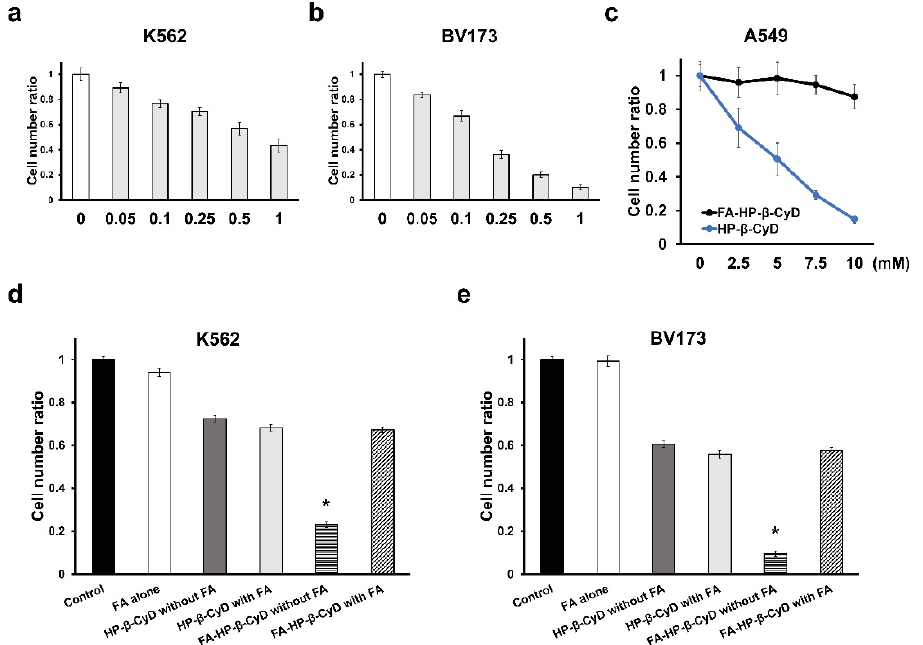
Figure 3. Antitumor effect of FA-HP- β -CyD. ( a , b ) Antitumor activity of FA-HP- β -CyD (0, 0.05, 0.1, 0.25, 0.5, and 1.0 mM) in K562 and BV173 cells. Cells were incubated with FA-HP- β -CyD for 72 h at 37 °C. ( c ) Antitumor activity of FA-HP- β -CyD and HP- β -CyD in A549 cells. Cells were incubated with 0, 2.5, 5, 7.5, and 10 mM of FA-HP- β -CyD or HP- β -CyD for 72 h at 37 °C. ( d , e ) Treatment with FA-HP- β -CyD in the presence or absence of FA. K562 and BV173 cells were incubated for 2 h at 37 °C with medium only (control), medium containing FA-HP- β -CyD (5 mM) and HP- β -CyD (5 mM) ments. * p < 0.05. The cell number ratio is the number of cells calculated with the number of cells in the control as 1.